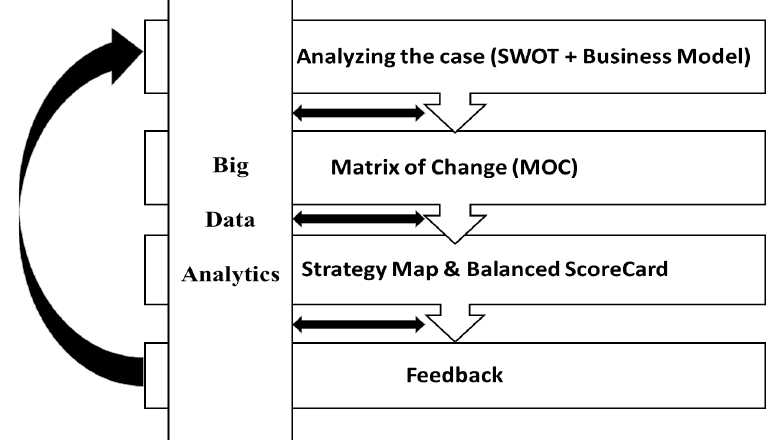
Fig. 5. Revenue Boosting